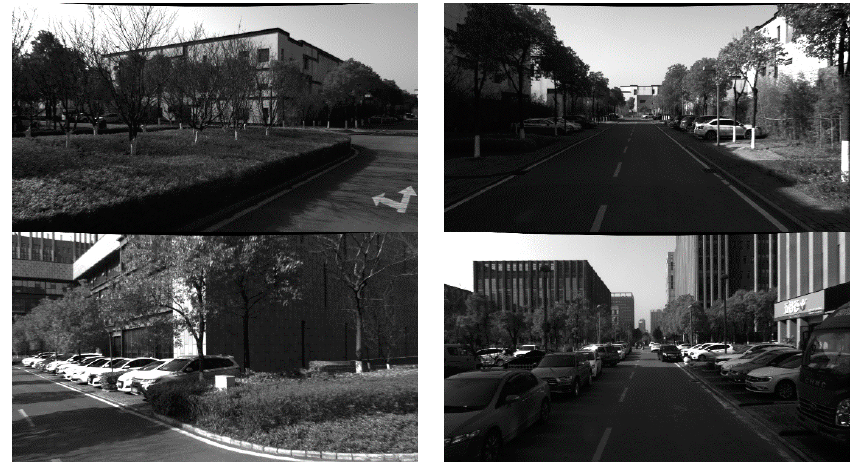
Figure 3. Representative images from our dataset.